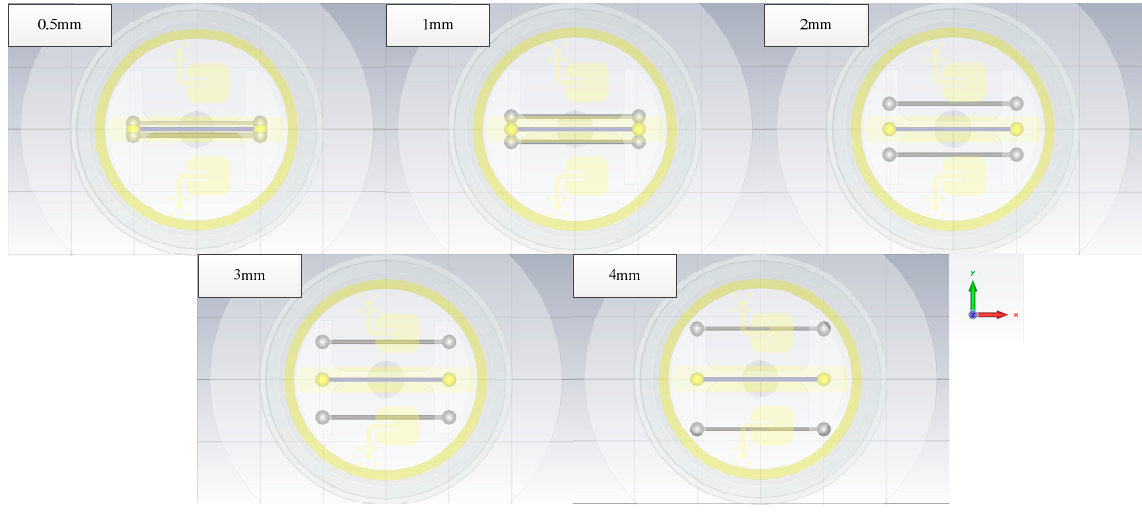
Figure 21. The geometry of the wires.